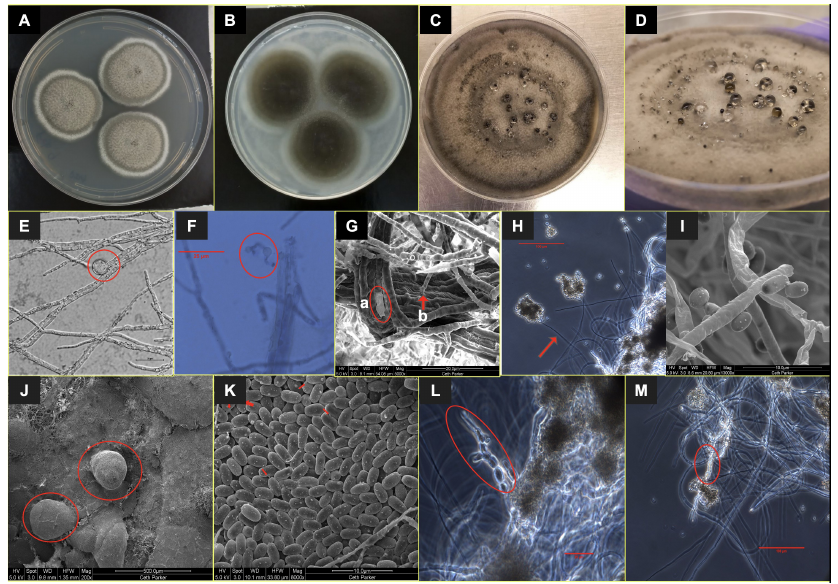
Figure 1. Colony and cell morphology of A. pasadenensis . Colony surface of A. pasadenensis after 8 days of incubation at room temperature (25 ◦ C) on ( A ) PDA medium and ( B ) OMA medium. ( C , D ): Round, immersed, brown to black conidiomata on an aged PDA plate. ( E , F ): Early age liberated conidia that are germinating. ( G ): Conidiogenous cells, encircled ( H , I ): Late-stage elongated conidiophore (arrow) and conidia. ( J ): Conidiomata. ( K ): Conidia and red markups showing CATs. ( L , M ):